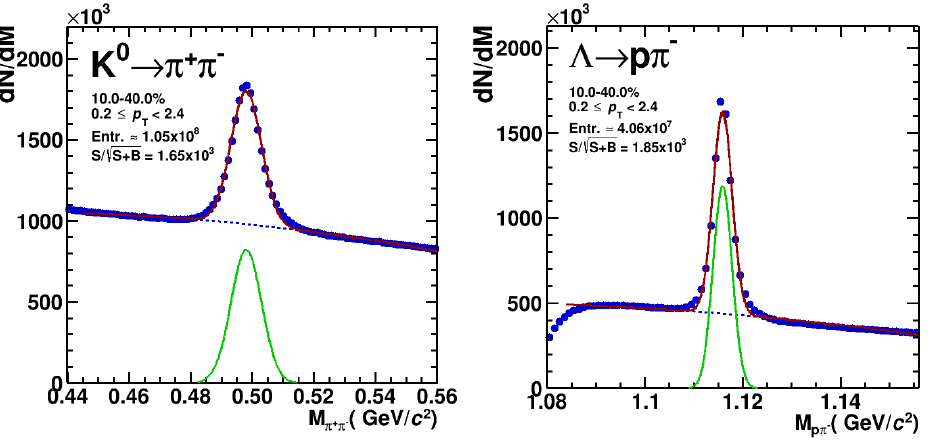
Figure 5. Invariant mass distributions for K 0 central Au + Au collisions at